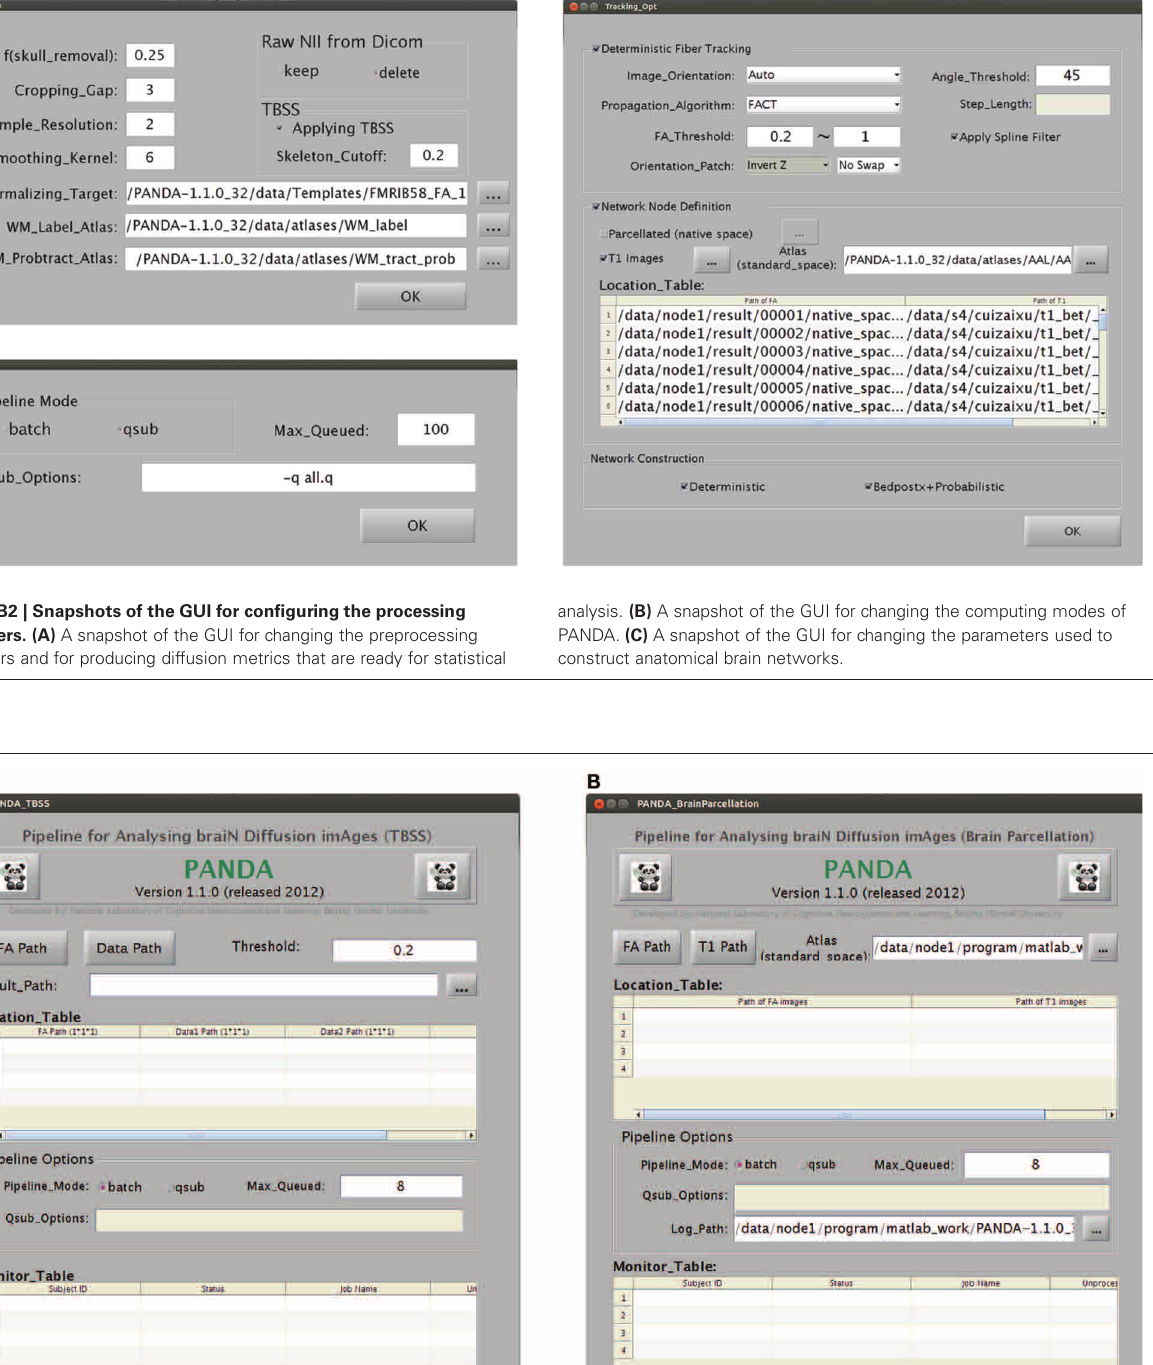
FIGURE B3 | GUIs for the utilities “TBSS” and “brain parcellation” in PANDA. (A) The utility for TBSS analysis. (B) The utility for brain